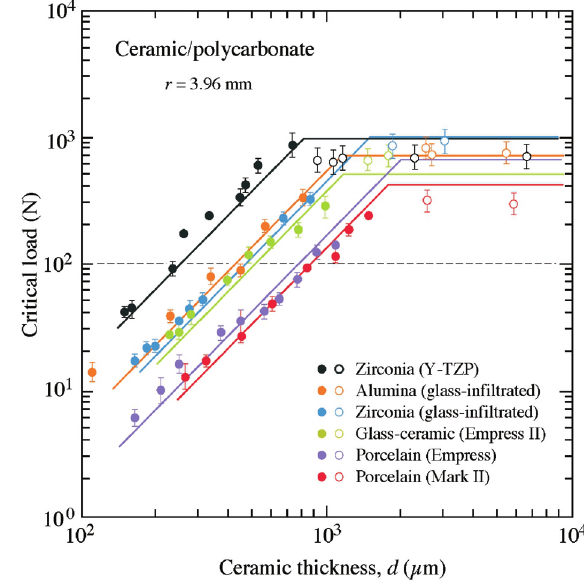
FIGURE 4 - Critical loads P for first damage in ceramic/ polycarbonate bilayers as function of ceramic thickness d , for indentation with WC sphere ( r = 4 mm), for a range of dental ceramics. 18 Symbols are experimental data (standard deviation bounds). Solid lines are theoretical predictions for cone cracking and quasiplasticity (horizontal lines) and radial cracking (inclined